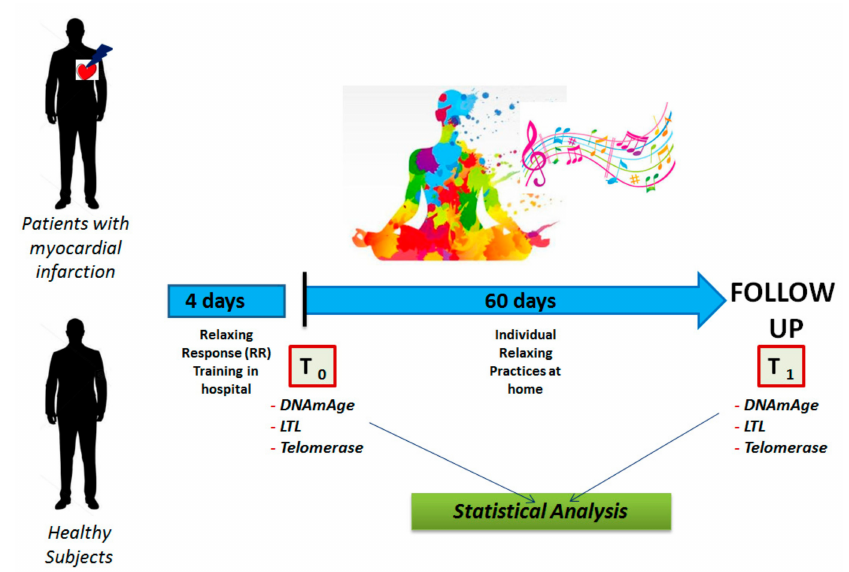
Figure 1. Longitudinal Plan of the